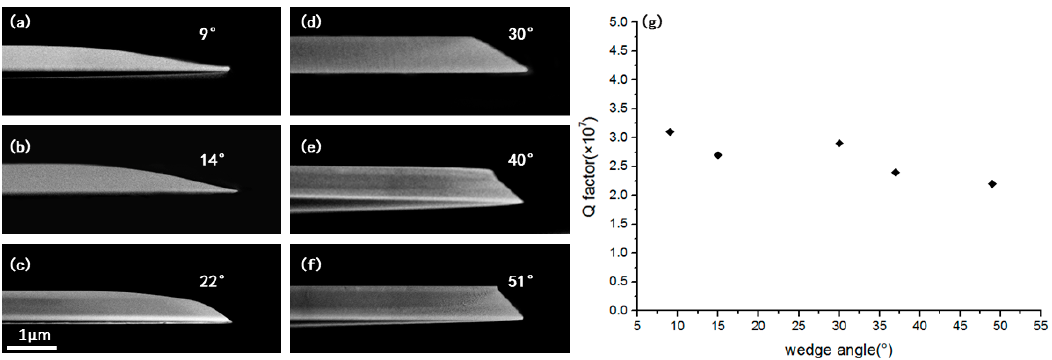
Figure 5. ( a – f ) Side view scanning electron microscope (SEM) image of the fabricated LN microdisks with different wedge angles of 9°, 14°, 22°, 30°, 40°, and 51°, respectively. ( g ) Q factors of the microdisks with different wedge angles.